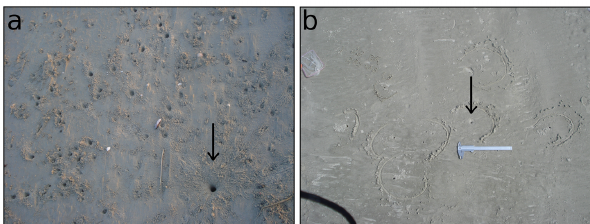
Figure 7. Examples of misleading situations. Examples of sets of burrows of Ocypode quadrata at Una Beach, southeastern Brazil. All these burrows showed signs of recent occupation, but only one was more than 10 cm deep and was the only occupied burrow (arrows). This may be more (a) or less (b) obvious from a superficial assessment.